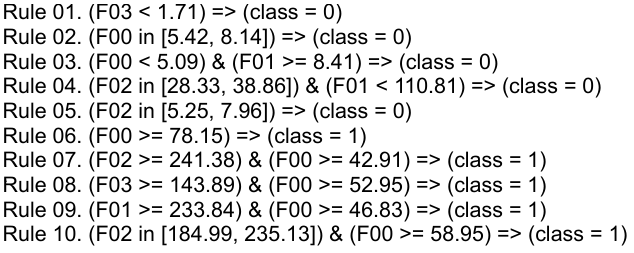
Figure 3. Ten samples out of the complete set of rules obtained from MODLEM